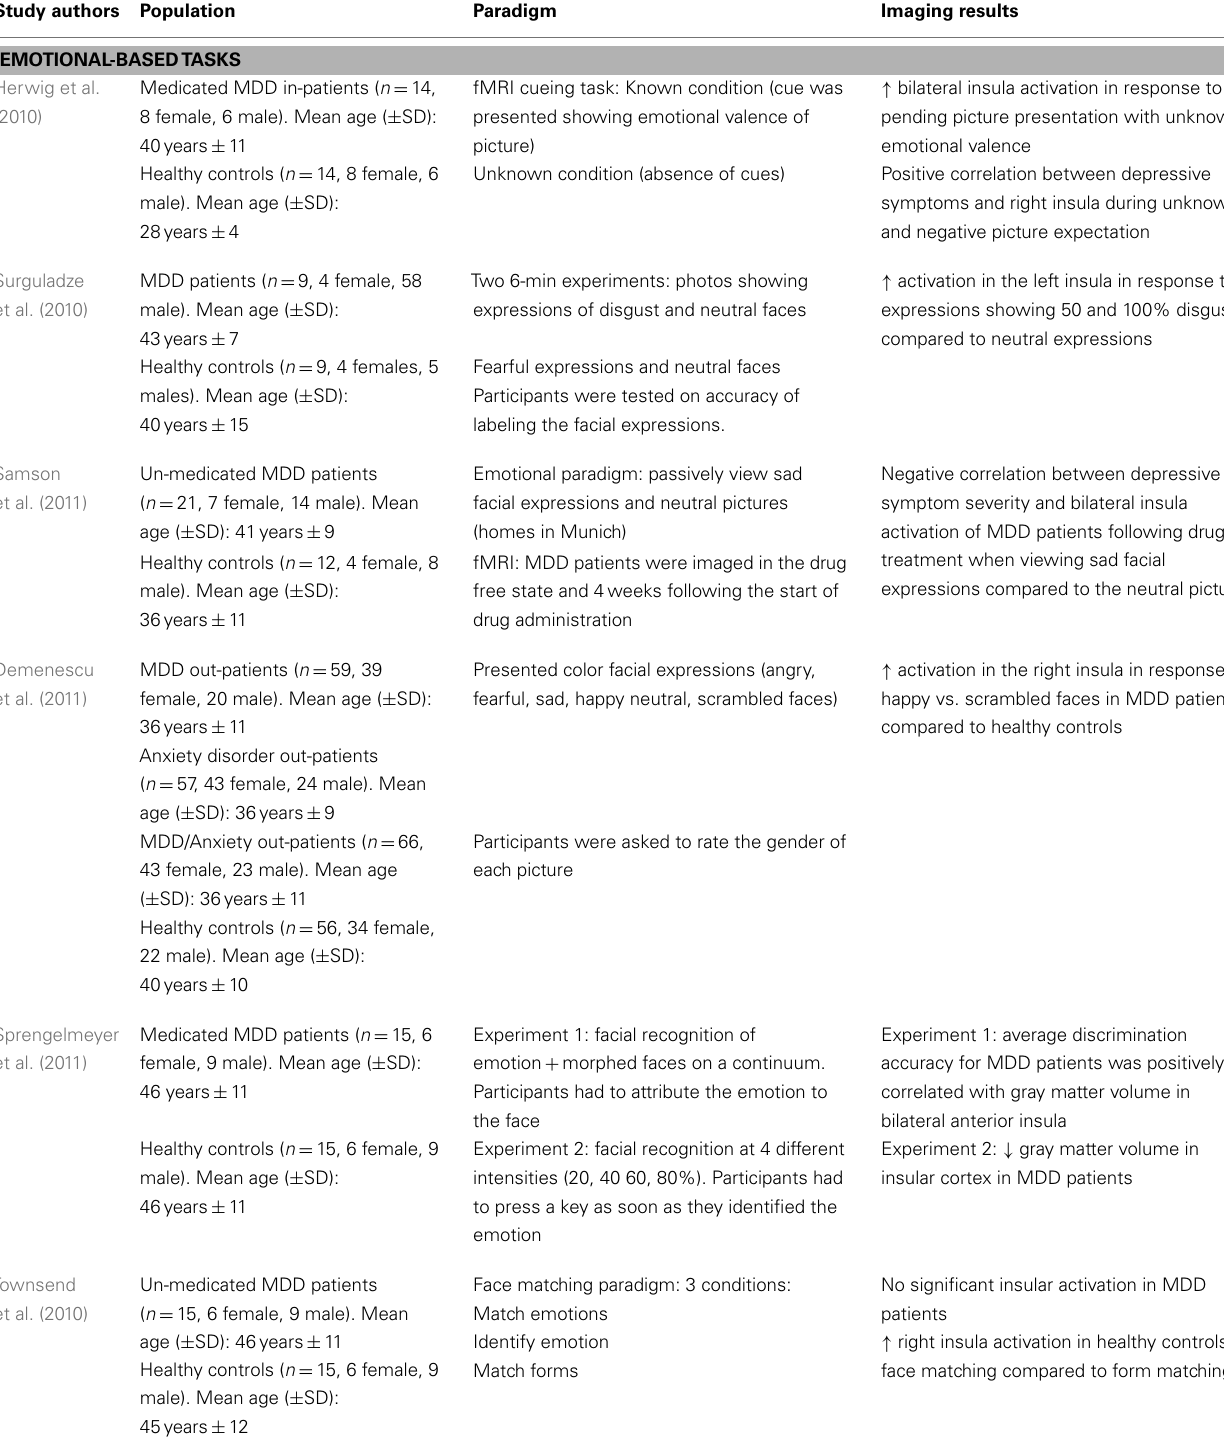
Table 3 | Imaging studies using emotionally based paradigms to examine functional and structural abnormalities in major depressive disorder